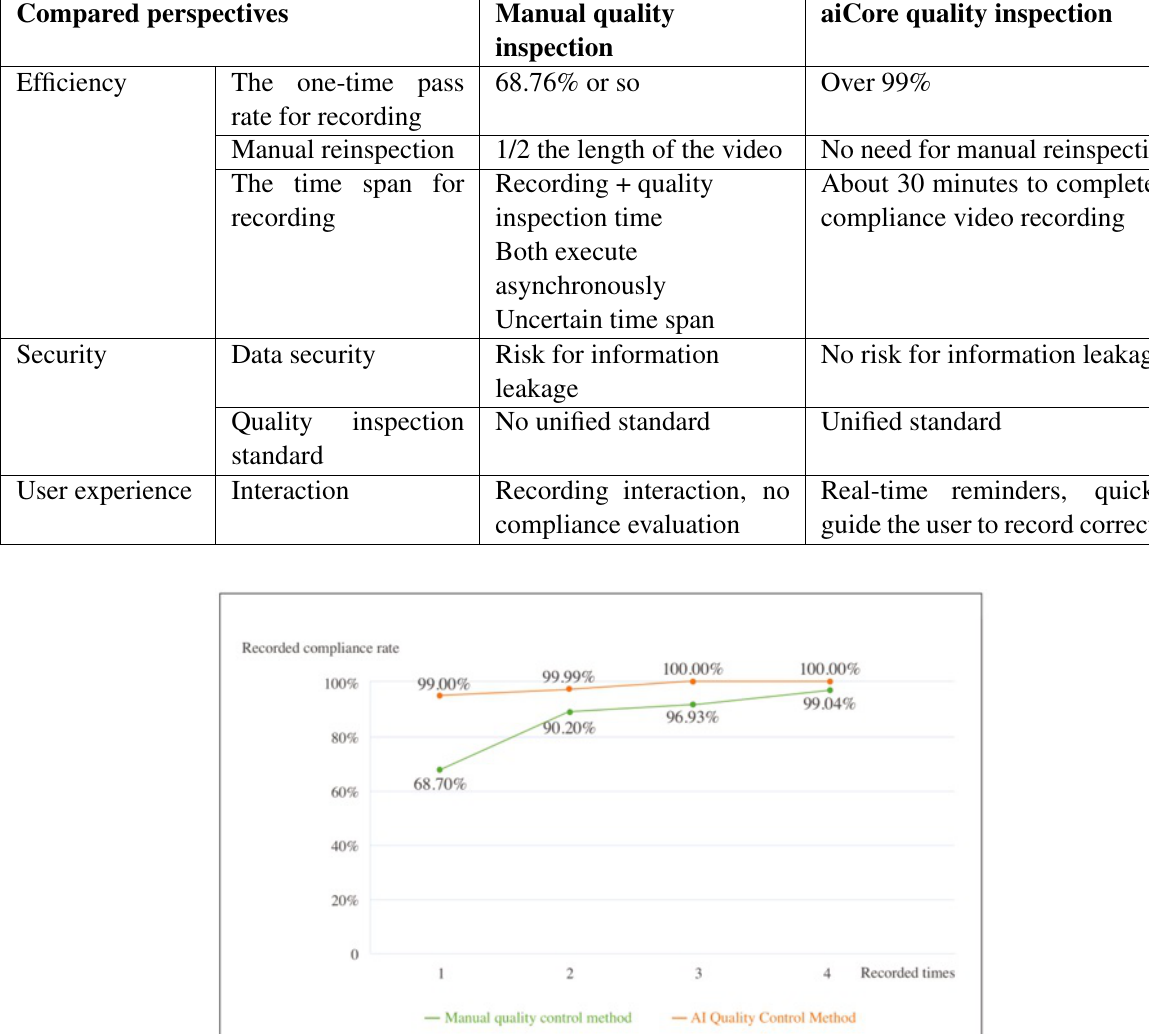
Table 1 The overall comparison between manual quality inspection and aiCore quality inspection